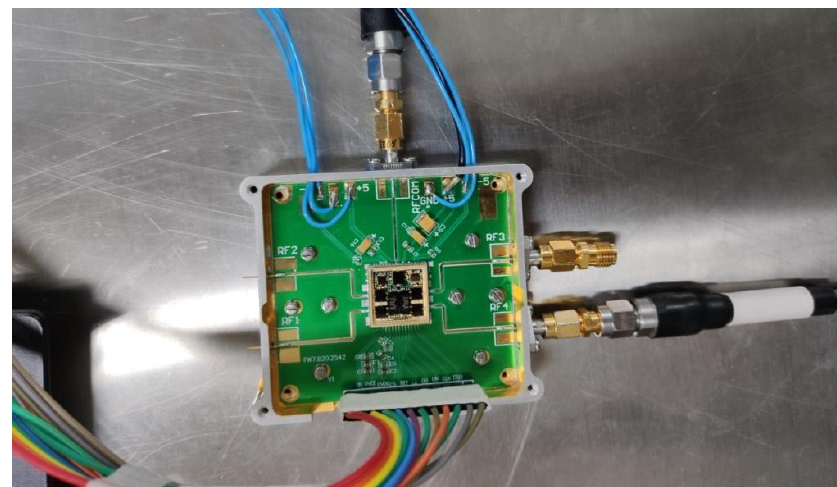
Figure 8. Test fixture of the proposed transceiver SIP.